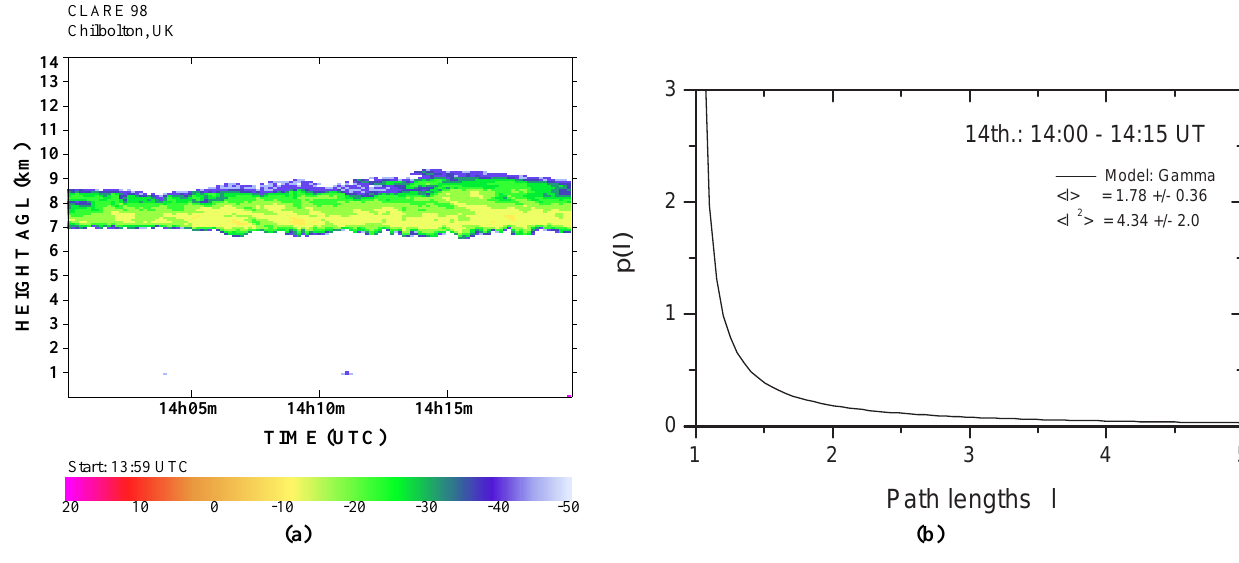
Fig. 4. (a) Cloud structure (backscatter ratio) measured by the 94GHz cloud Radar MIRACLE. (b) A high cirrus cloud layer reduces the mean photon path length compared to the clear sky, due to an increased probability for a nearly vertical path after a scattering event in high